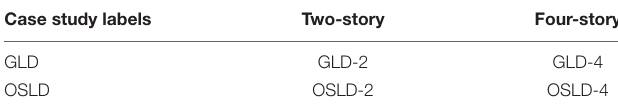
TABLE 4 | Case study buildings